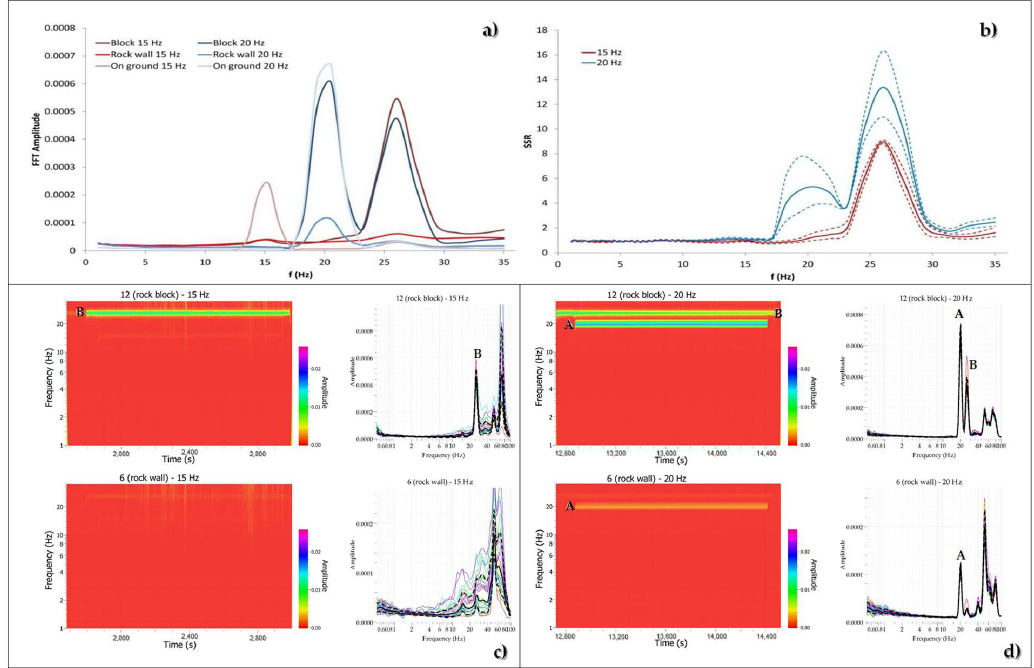
Figure 8. Fast Fourier transform, FFT ( a ), and block/wall SSR ( b ) obtained for the 15 Hz and 20 Hz shaking tests. The rock block dynamic amplification response at 20 Hz is visible (blue line– b ). Dashed lines indicate the standard deviation values. Time-frequency analyses and spectral analyses obtained for the 15 Hz ( c ) and 20 Hz ( d ) shaking tests: on the rock block (up) and on the rock wall behind (bottom). Markers on the spectrograms indicate frequencies due to Vibrodyne excitation (A) and to the power unit supply (B). For the 20 Hz excitation, the possible dynamic response of the monitored rock block can be distinguished.